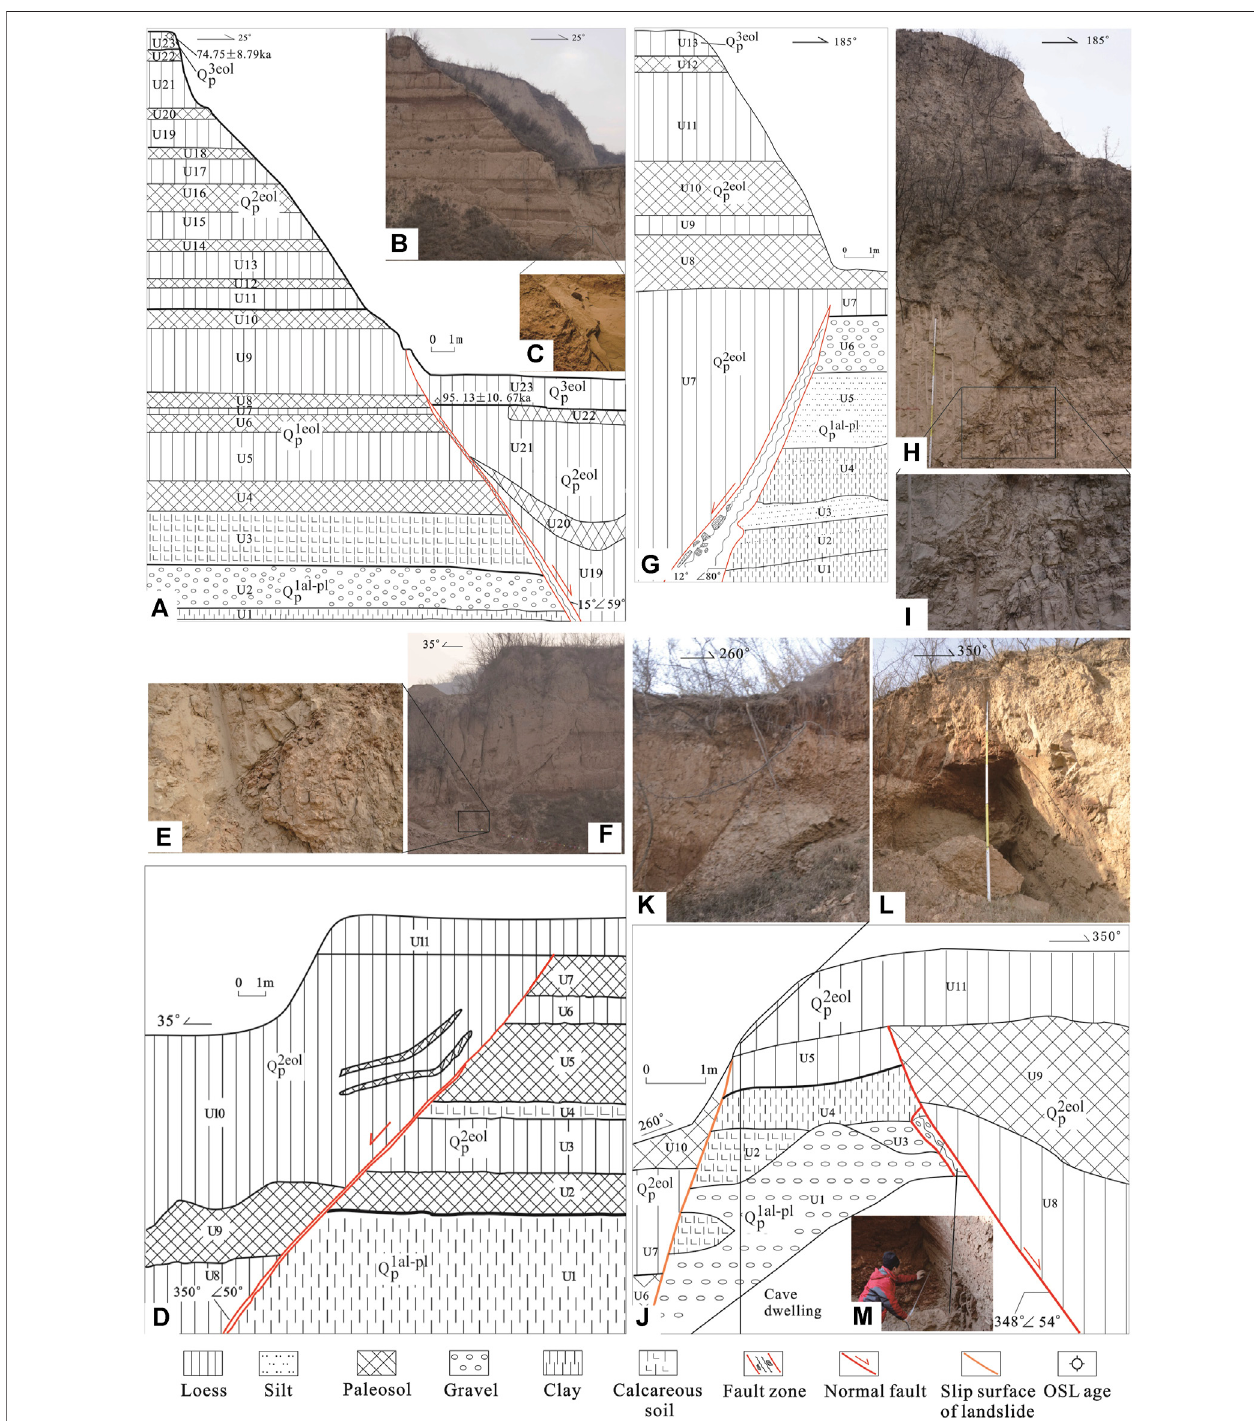
FIGURE 2 | The photographs and explanation of the typical outcrops of Kouma Fault. (A) The geological pro fi le of G1 outcrop. (B) The panoramic photographs of G1. (C) The photographs of fault zone of G1 outcrop. (D) The geological pro fi le of G2 outcrop. (E) The photographs of fault zone of G2 outcrop. (F) The panoramic photographs of G2. (G) The eological pro fi le of G3 outcrop. (H) The panoramic photographs of G3. (I) The photographs of fault zone of G3 outcrop. (J) The geological pro fi le of G6 outcrop. (K) The photographs on the left of G6. (L) The photographs on the middle and right of G6. (M) The photographs of fault zone of G6 outcrop.